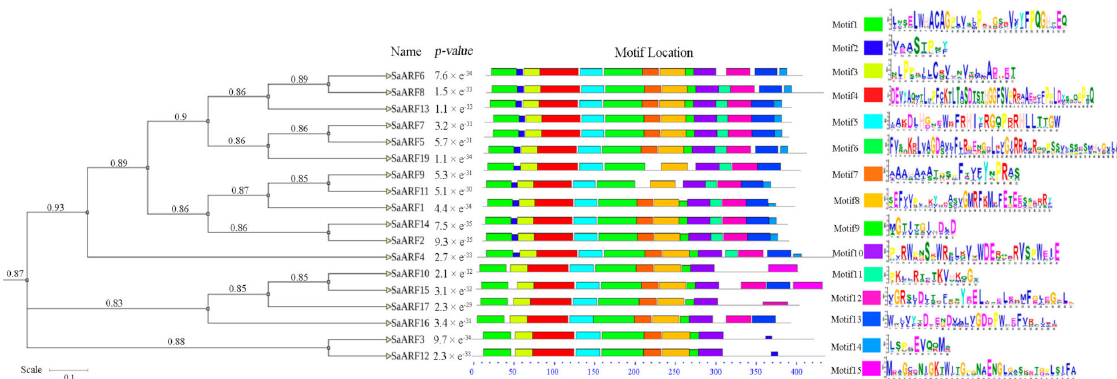
Figure 1. Conserved motif analysis and phylogenetic tree of gene families. Analysis diagram of conserved motifs of the ARF gene family in sandalwood. Phylogenetic tree and distribution map of conserved motifs of the SaARF gene family. The conserved motifs of the SaARF gene family were analyzed by MEME, and the length of the conserved motifs was set to 6–50 aa. The number was 15, and they were distinguished by different colors. Multiple sequence alignment of S. album ARF proteins was performed using MUCLE, and adjacency (NJ) trees were constructed using MEGA X to combine conserved motif analysis with evolutionary trees of the SaARF gene